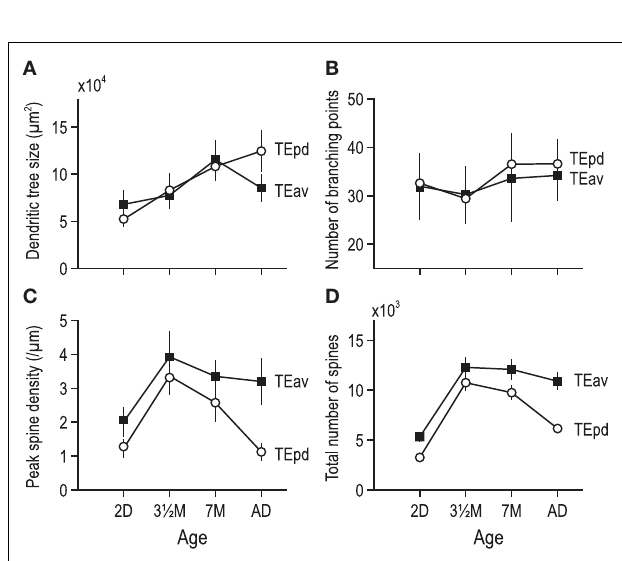
FIGURE 3 | Plots of size (A) , number of branching points (B) , peak spine density (C) , and total number of spines (D) in the basal dendritic trees of layer III pyramidal neurons inTEav sampled from animals 2days old (2D), three and a half months old (3.5month), 7months old (7month), and 4.5years old (Ad). Error bars = SD.